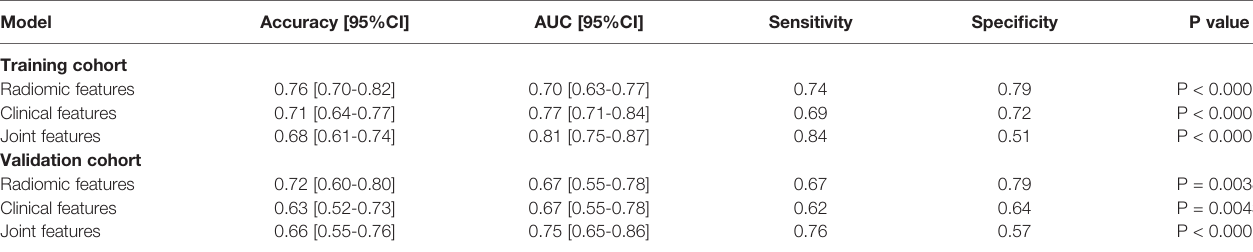
TABLE 2 | Predictive performance of the three models in the training and validation cohorts.